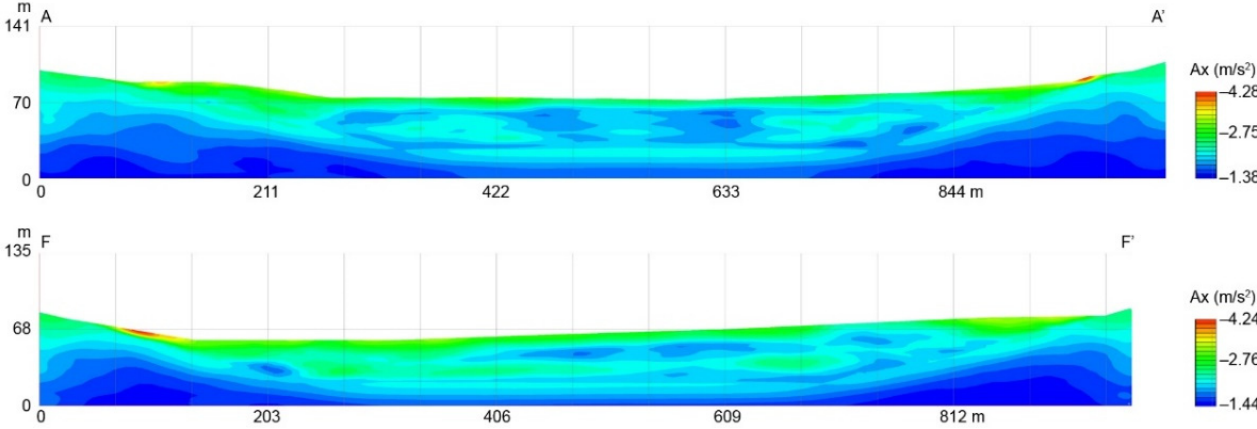
Figure 12. Maximum horizontal acceleration obtained by the numerical modeling of the cross-sections A–A’ and F–F’ (see Figures 8 and 9) at the Poggio Cancelli valley.